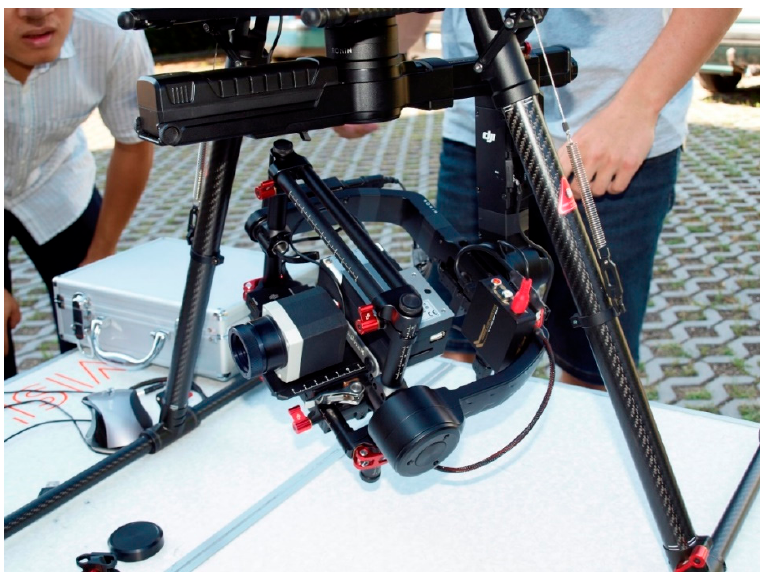
Figure 2. The infrared camera in